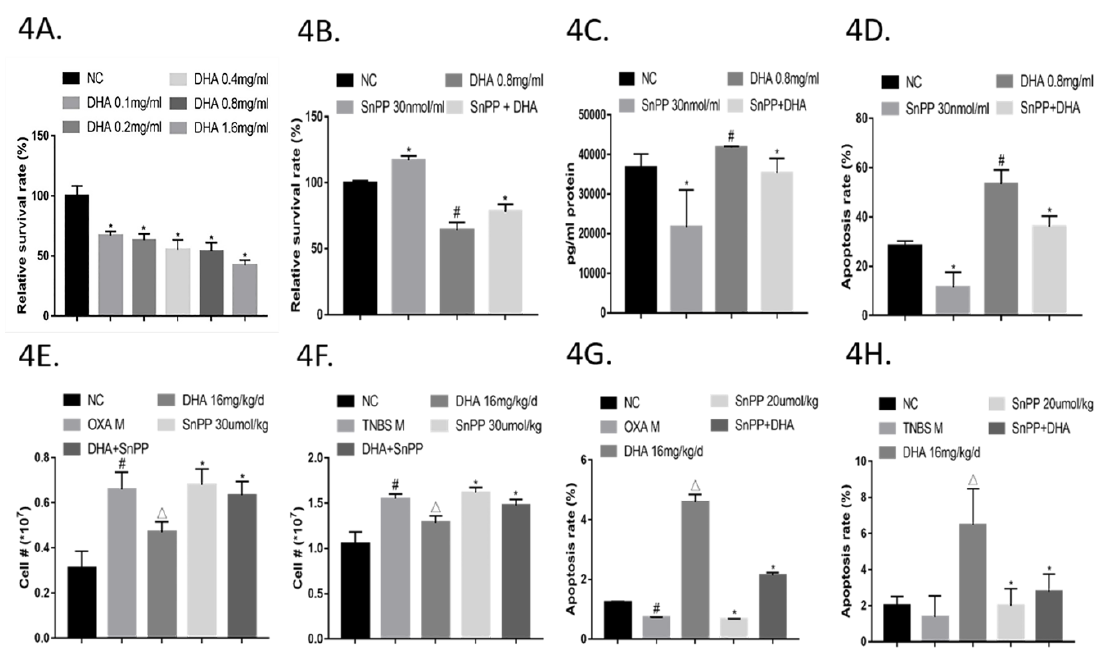
Figure Figure 4. Dihydroartemisinin (DHA) suppresses activated CD4+ T cell subsets by inducing apoptosis via HO-1. ( 4A ) Purified spleen CD4+ T cells were activated with plate bound anti-CD (Cluster of